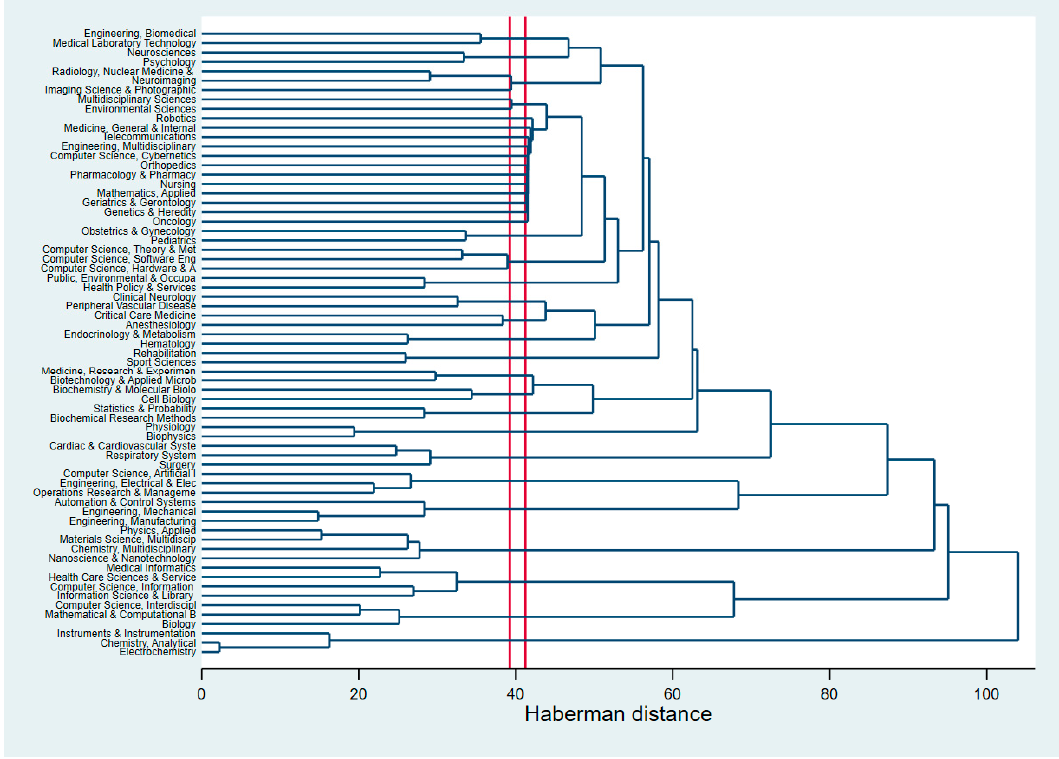
Figure 5. Dendrogram of research areas using the WoS classifications.